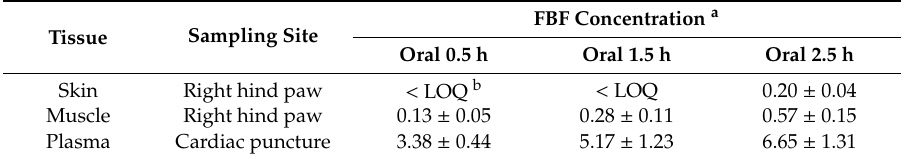
Table 5. FBF biodistribution after oral delivery ( n =